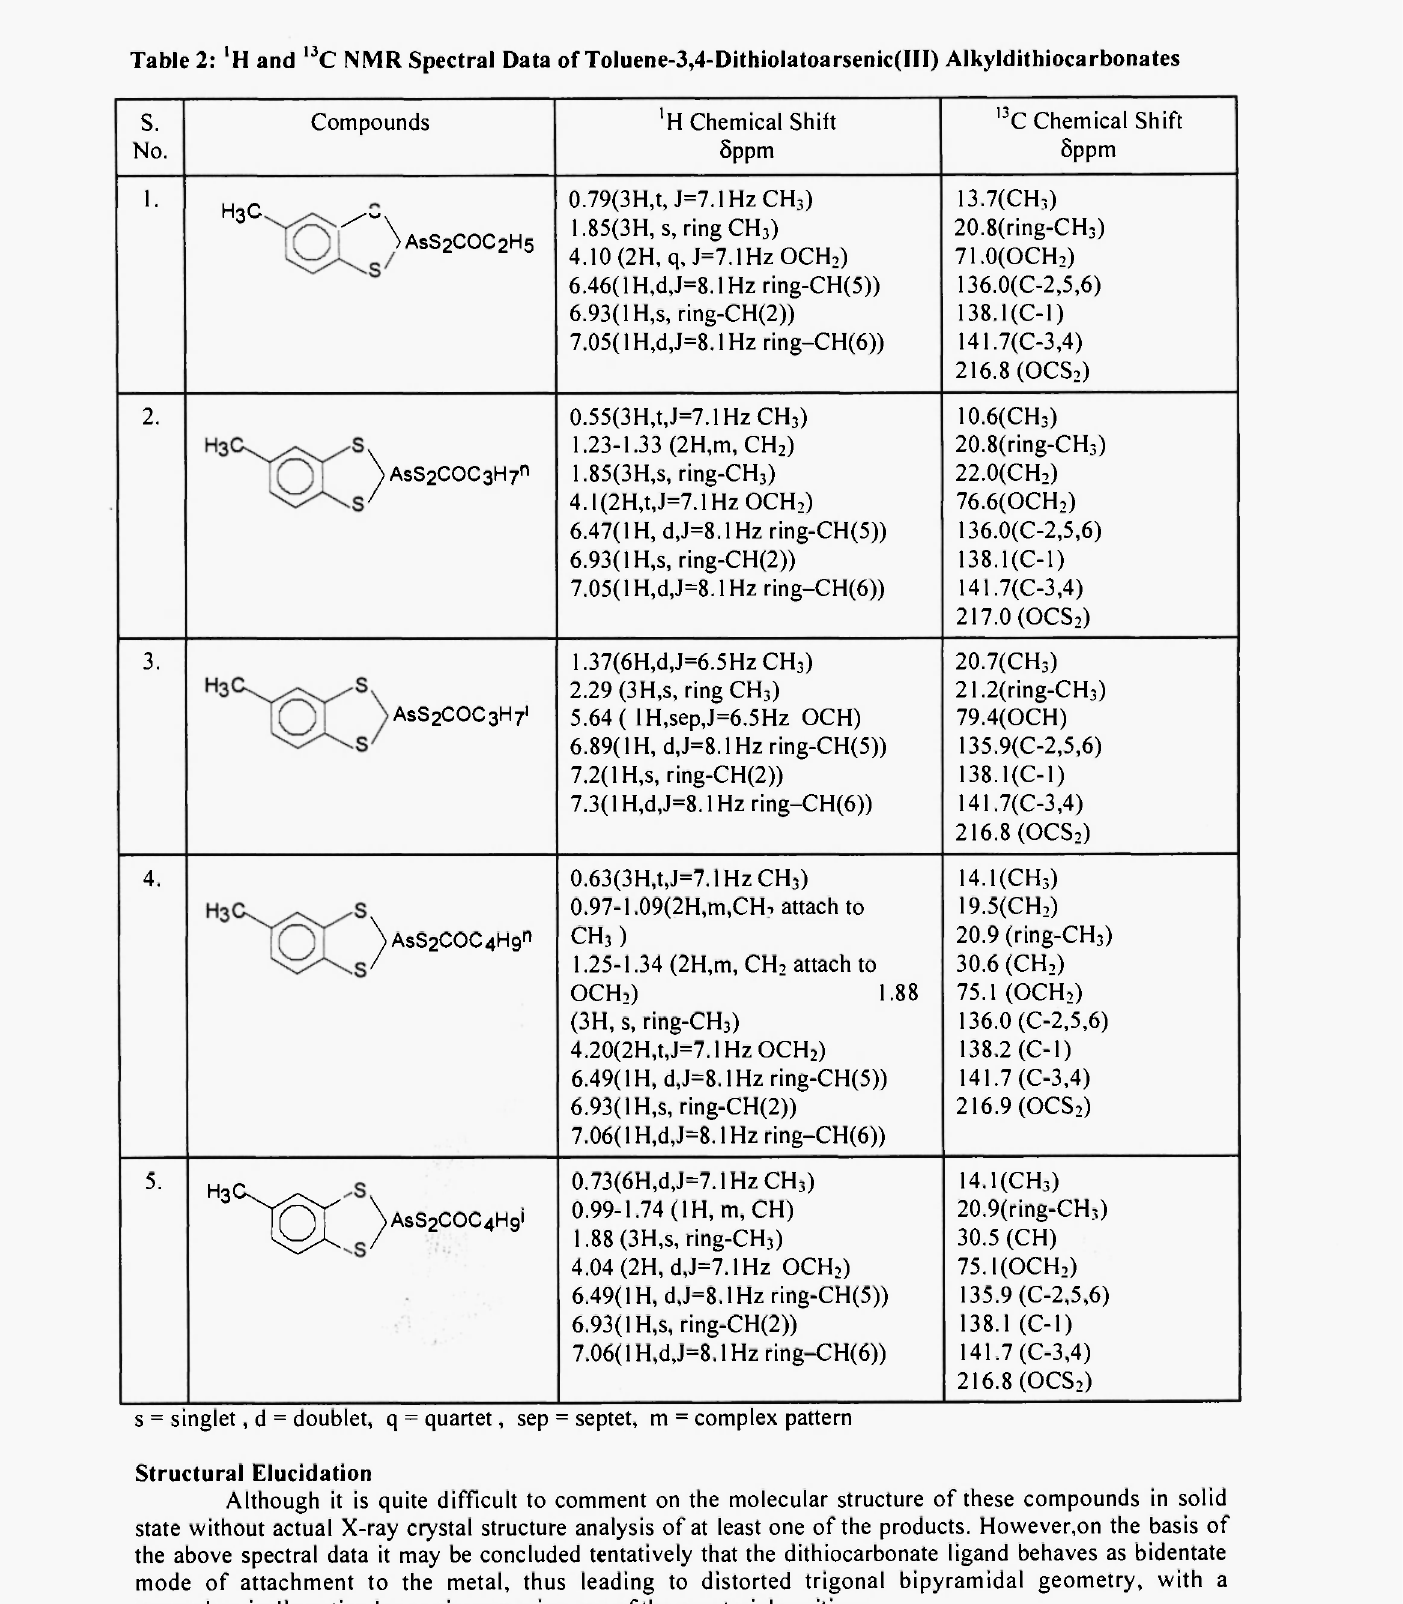
Table 2: 'H and 13 C NMR Spectral Data of Toluene-3,4-Dithiolatoarsenic(III) Alkyldithiocarbonates